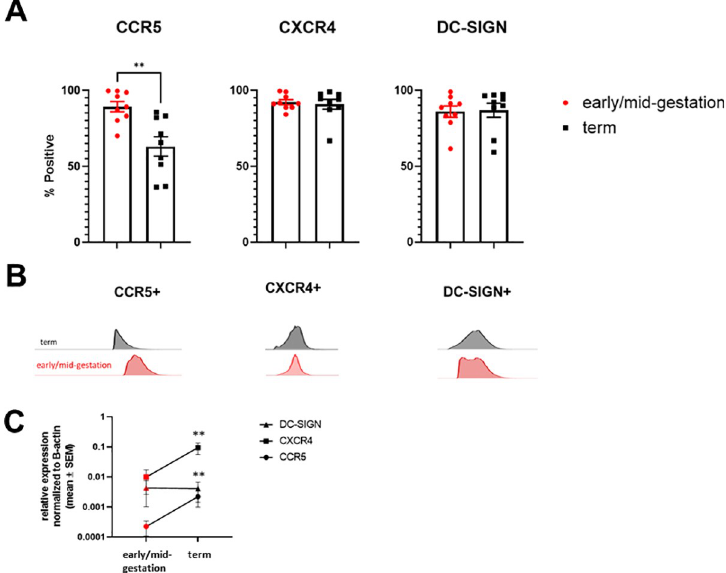
Fig 1. Early/Mid-Gestation HCs express Higher Protein Surface Levels of CCR5 compared to Term HCs. A , Surface expression of CCR5, CXCR4 and DC-SIGN was determined by flow cytometry on freshly isolated HCs from early/mid-gestation (red markers) and term (black markers) placental tissue. Data shown are expressed as the mean ± standard error of biological triplicates from 10 individual donors analyzed by unpaired t-test analysis using the two-stage linear step-up procedure of Benjamini, Krieger and Yekutieli. �� p < 0.001 indicates significance between early/mid-gestation HCs compared to term HCs. B , Representative flow cytometry histograms of typical distributions of fluorescence intensity (along x axis) are provided. C , Messenger RNA levels were measured by qRT-PCR to determine the relative expression of CCR5, CXCR4, and DC-SIGN. Gene expression data are represented as fold change normalized to β -actin ( ΔΔ cycle threshold method). �� p < .001 indicate significance between early/mid- gestation HCs compared and term